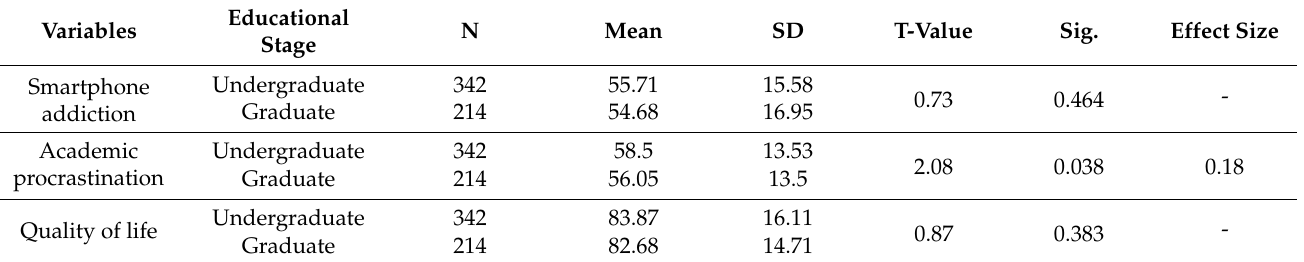
Table 3. The differences between undergraduate and graduate students in smartphone addiction, academic procrastination, and quality of